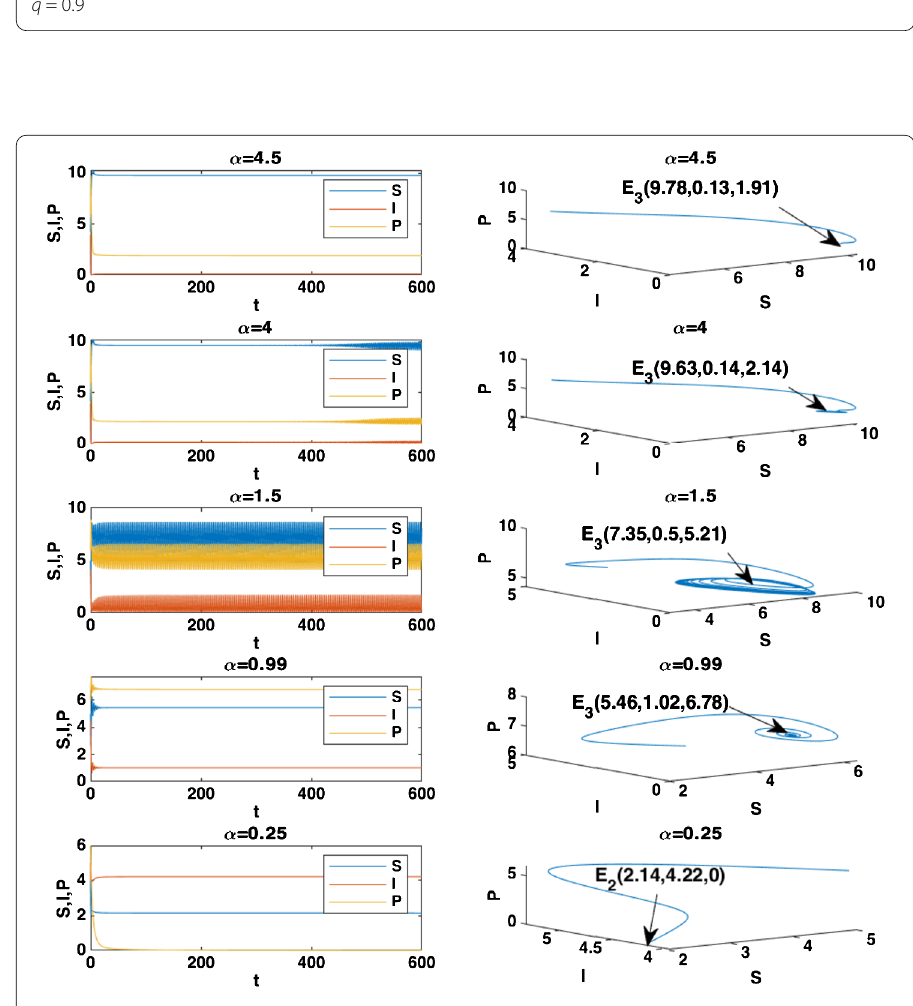
Figure 10 Time series and phase diagram of the fractional-order model (3) with different values of predator’s attack rate ( α ) when q =